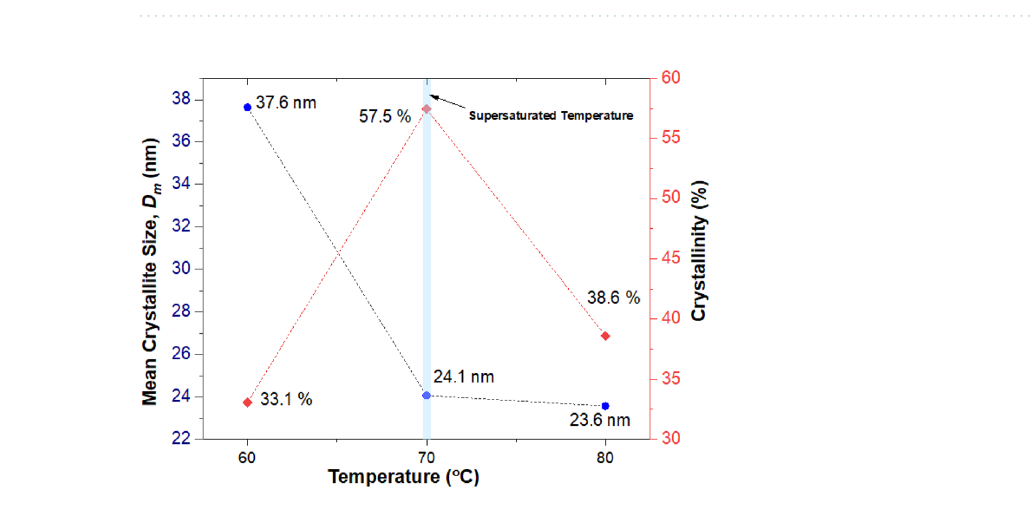
Table 3. Crystallographic parameters consist of the lattice parameters and unit cell volume of CuO/Cu 2 O nanostructures with the wavelength of Cu Kα radiations at (cid:31) = 1.5406 Å.